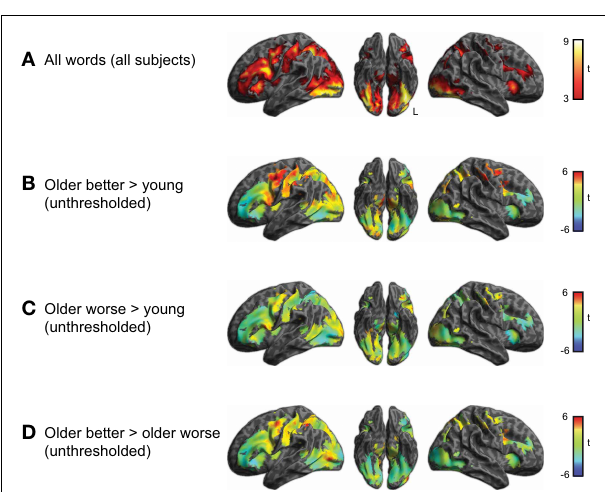
FIGURE 3 | (A) Brain activity associated with semantic task for young and older adults together (voxelwise p < 0 . 001, cluster-level corrected q < 0 . 05). This result was used to mask the unthresholded comparisons shown in the remaining panels. (B) Comparison between better-performing older adults and young adults. Positive t -values indicate more activity in the group of better performing older adults than young adults, negative values